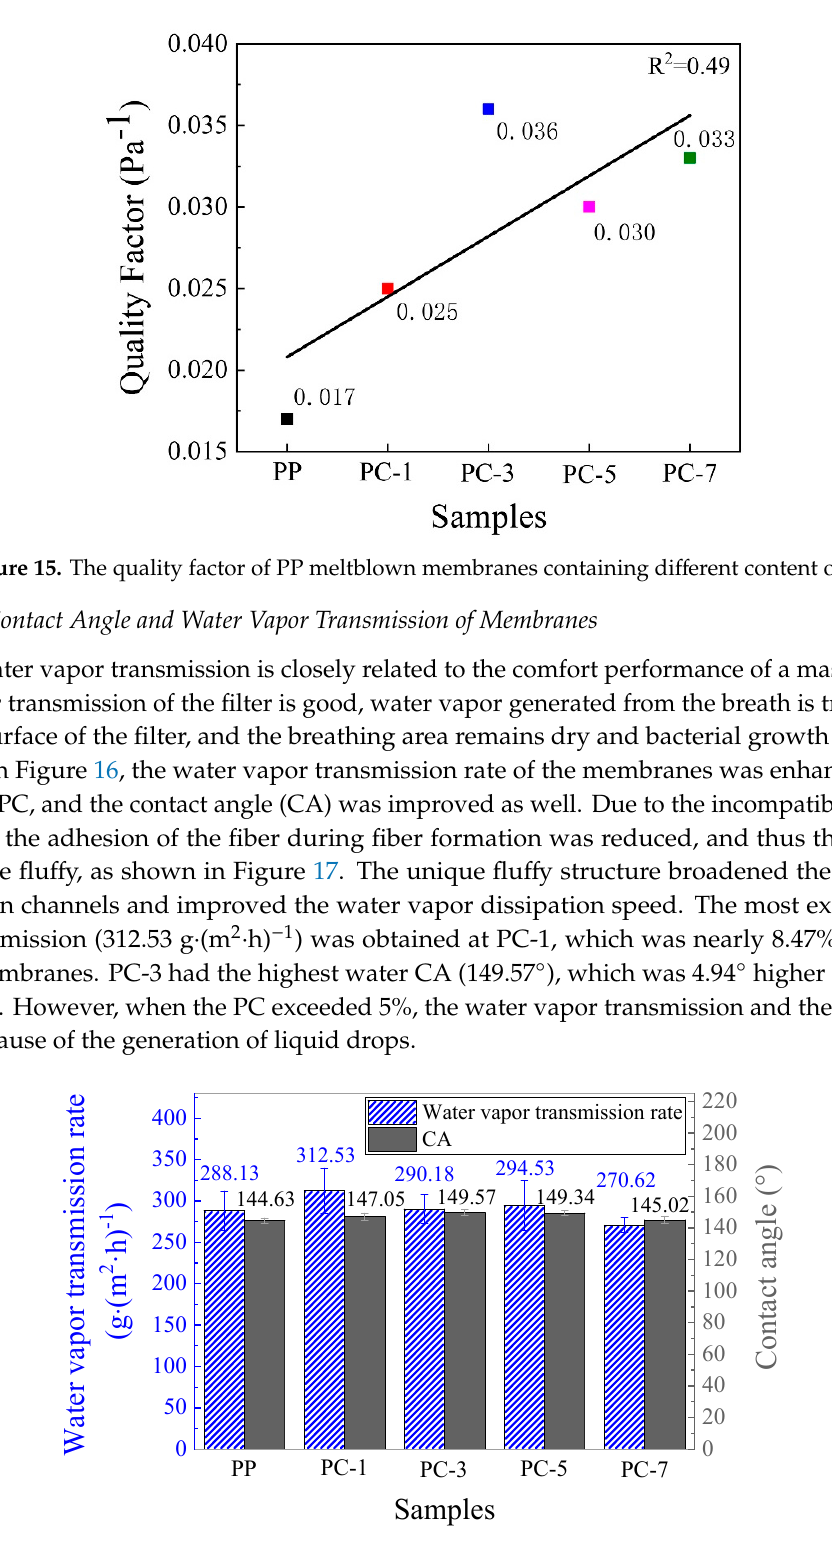
di ff erent PC different PC content.